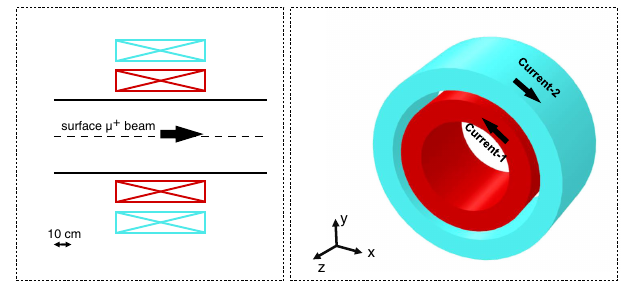
FIG. 14. Model 2: the dual-layer solenoid. The outer coil has the direction of current opposite to the inner coil (blue: the outside coil, red: the inner coil).